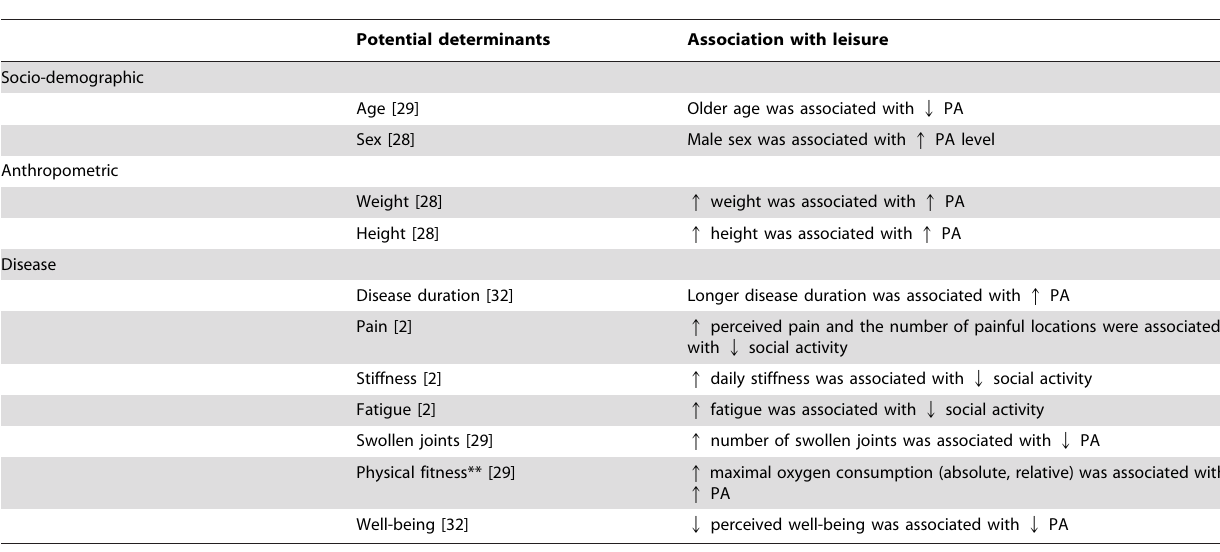
Table 2. Potential determinants of participation in leisure-time activities in JIA identified in the systematic